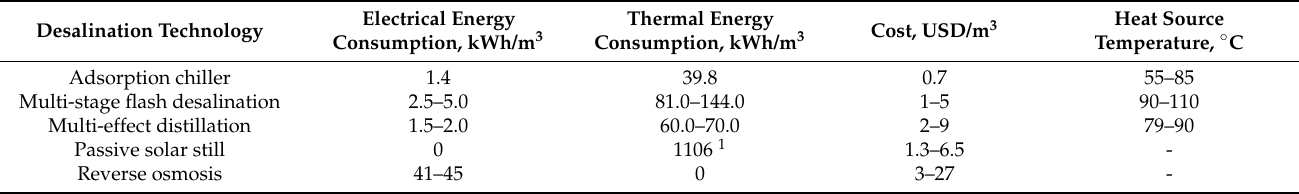
Table 1. Comparison of selected water desalination technologies coupled with solar energy. Based on [6]. Desalination